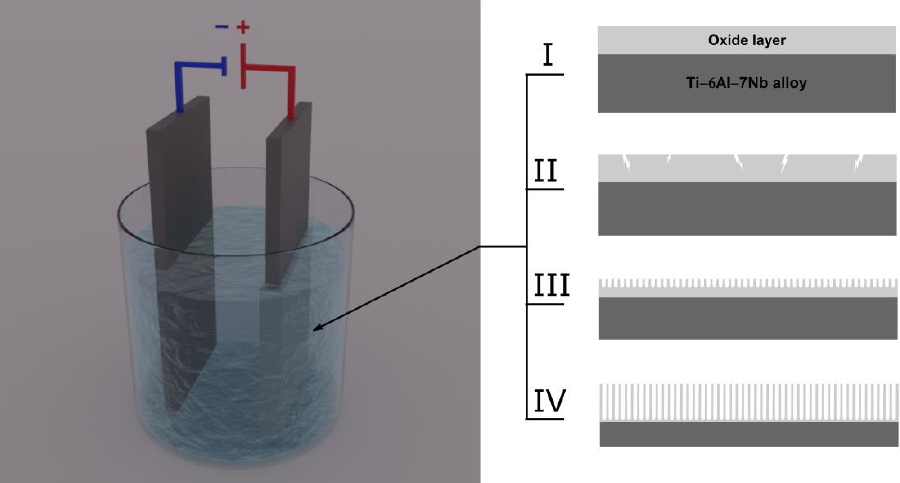
Figure 8. Diagram illustrating the multistep mechanism of oxide nanotube (ONT) formation on Ti–6Al–7Nb alloy during anodization in an aqueous solution of ethylene glycol containing fluoride ions: (Step I) formation of a compact oxide layer; (Step II) formation of pores; (Step III) formation and separation of ONTs; (Step IV) determination of the length of ordered ONTs.